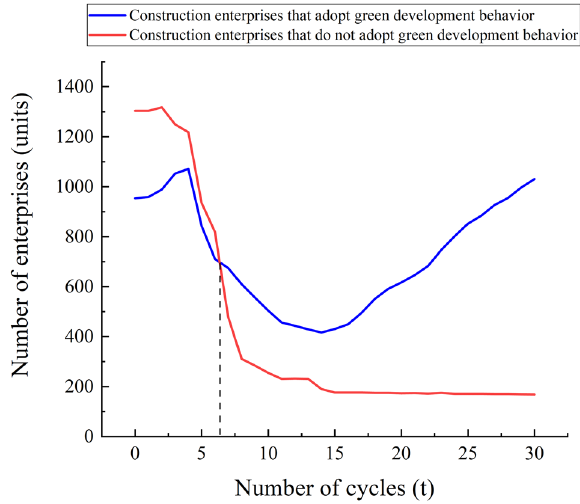
Fig. 7 The process of the in fl uence of sustainable environmental regulations on the scale of the green development behaviors adopted by construction enterprises. The moment marked by dotted lines in the picture represents the same number of construction enterprises that adopt green development behaviors and those who do not adopt green development behaviors under the effect of sustainable environmental regulations.